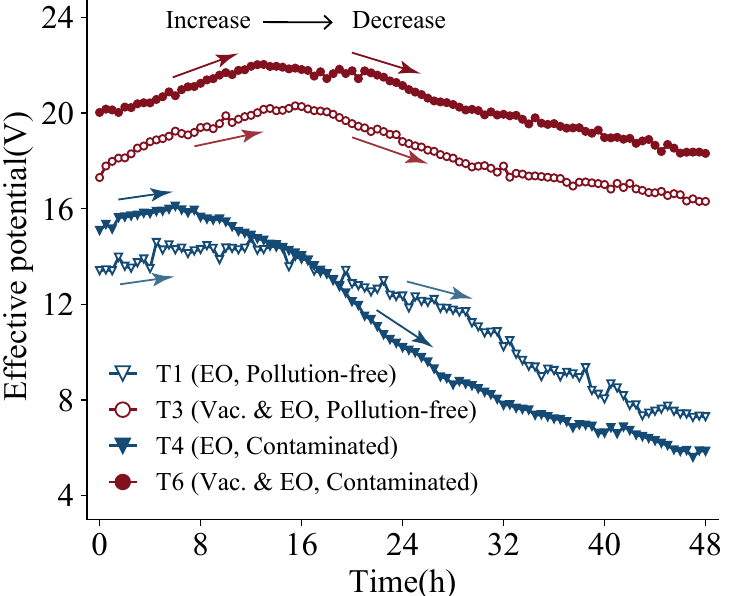
Figure 16. Change curve of effective potential with